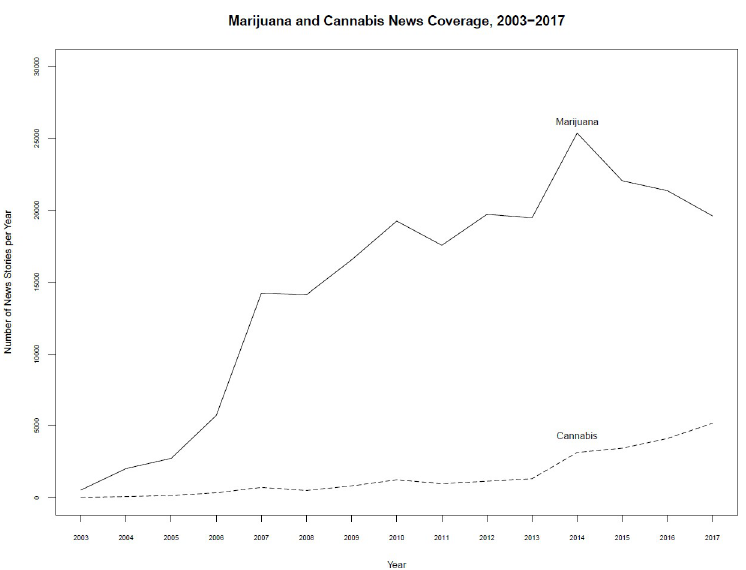
Fig 1. Mentions of “Marijuana” and “Cannabis” in US newspapers, 2003–2017. Source : Nexis-Uni searches of published stories in newspapers in the United States, Jan. 2003-Dec. 2017.